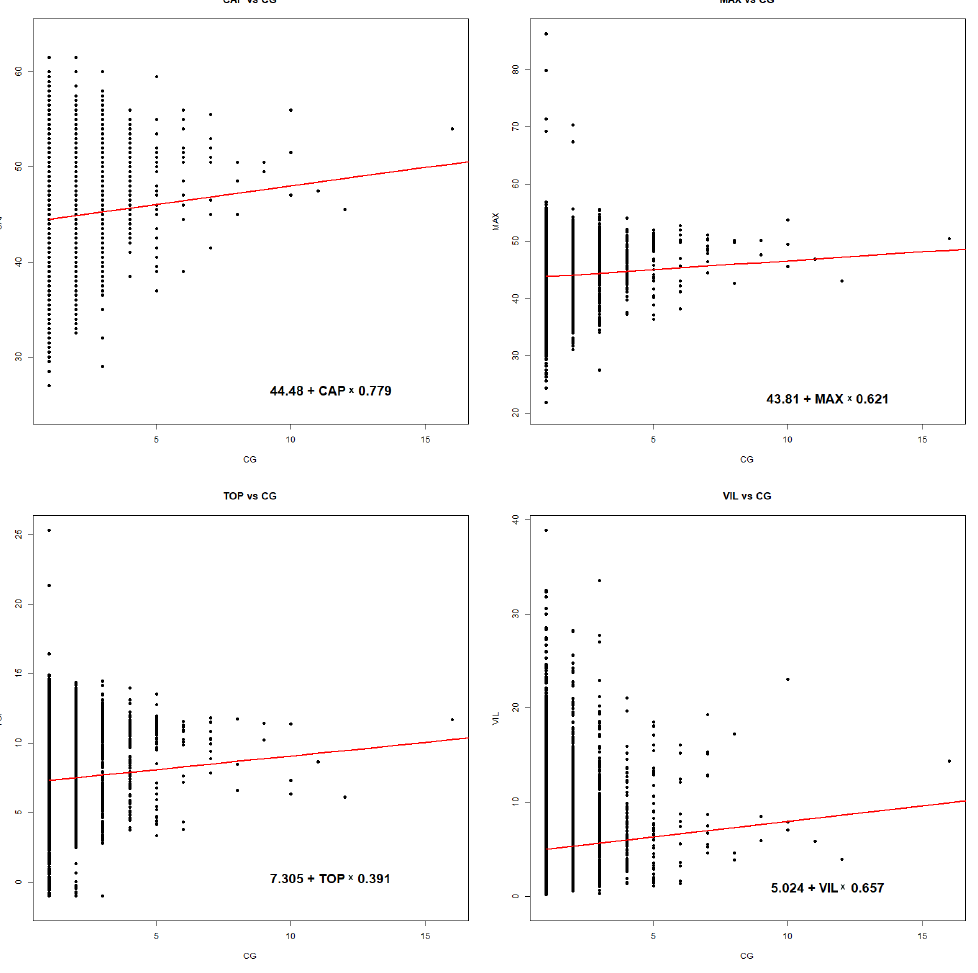
Figure 7. Scatterplots of CAP, MAX, TOP, and VIL in front of CG density for the same case of Figure 5. Red lines indicate the linear regression, while the equation at the bottom-right of each panel shows the coefficients for each